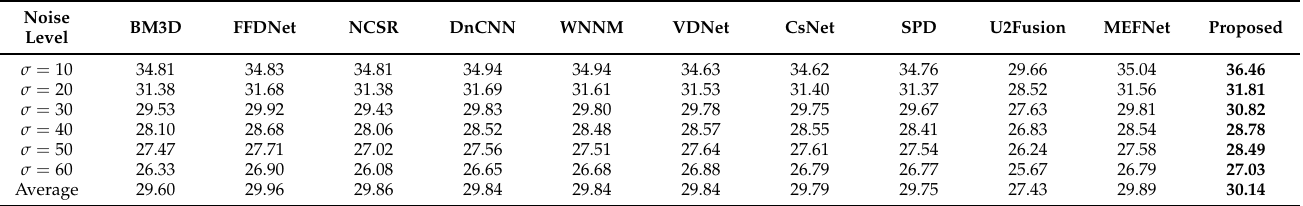
Table 5. Average PNSR results of different denoising methods on 10 commonly used images with various noise levels.